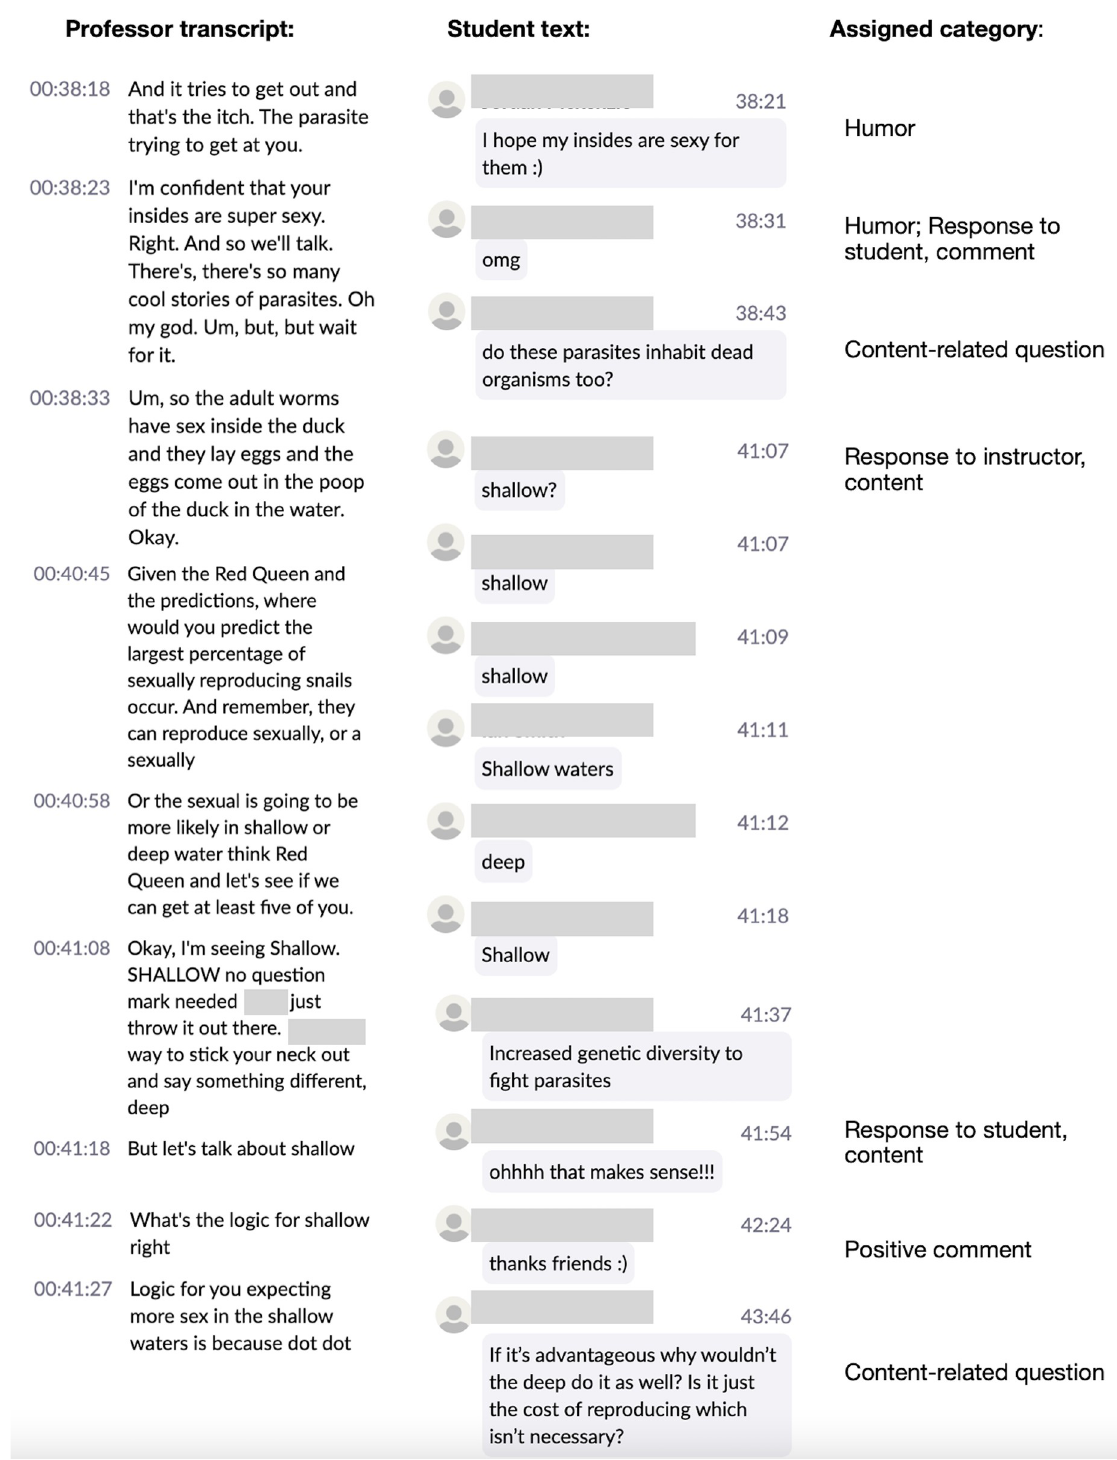
Fig 2. An example of student chatting, during a discussion of mate choice in peafowl, alongside instructor dialogue and how each student chat was coded.